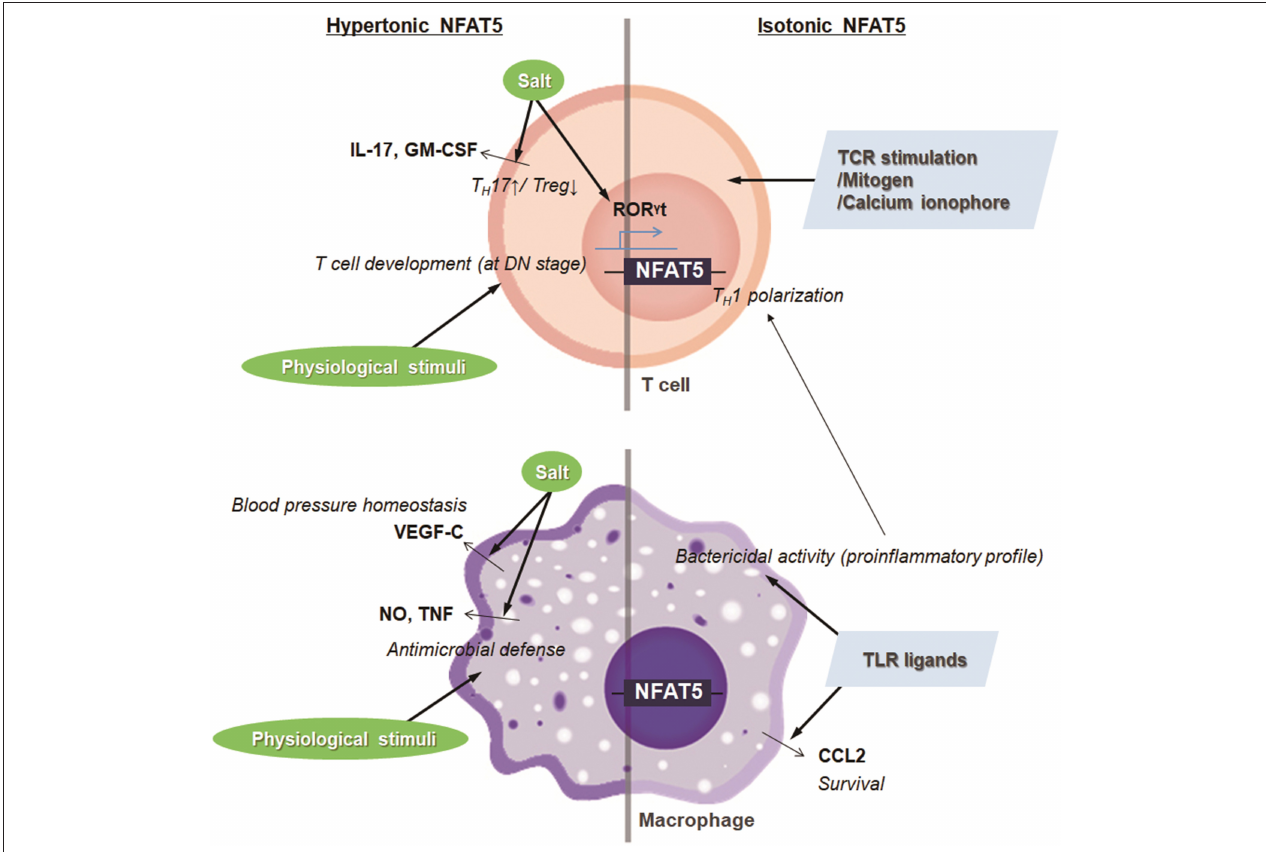
FIGURE 2 | Targets and immunologic functions of hypertonic and isotonic NFAT5. NFAT5 induced by hypertonic or isotonic stimuli maintains blood pressure homeostasis, induces T cell development and T H 17 cell differentiation, and enhances antimicrobial activity and cell survival of macrophages. In addition, NFAT5-mediated proinflammatory alteration in macrophages skews CD4 + T cells to T H 1